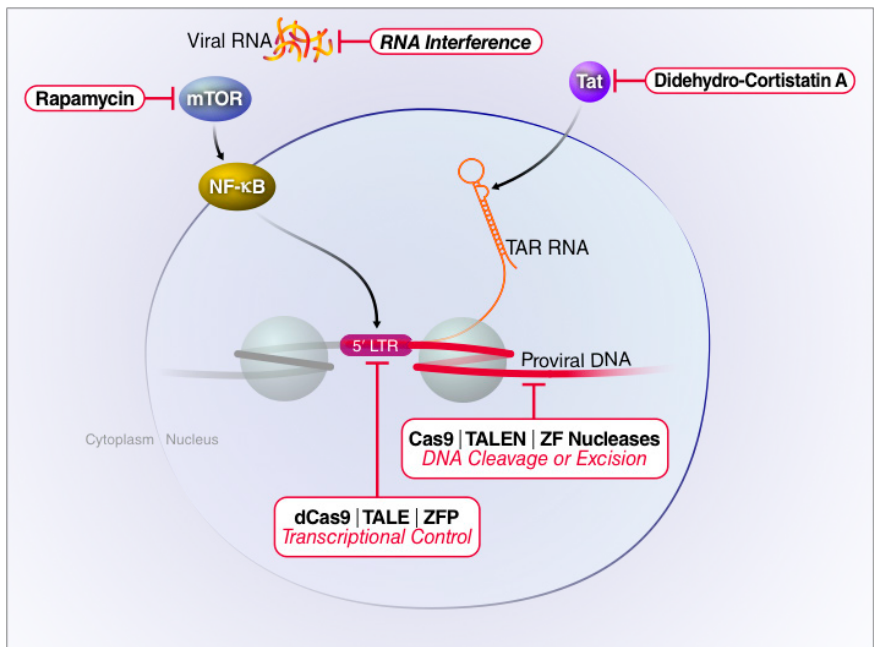
Figure 3. Targeting of host or viral factors to silence latent HIV proviruses. Therapeutics devised to inhibit HIV-1 replication may target different stages of the viral life cycle. The small molecule drug rapamycin blocks viral transcription initiation by inhibiting mTOR and AKT-mediated induction of NF- κ B. Didehydro-cortistatin A interferes with Tat-mediated transactivation by blocking Tat binding to TAR, thereby reducing RNA Pol II elongation. RNA interference predominantly acts by degrading viral transcripts. Gene editing technologies directly target proviral DNA by either excising or corrupting the viral genome. CRISPR interference (CRISPRi) does not cleave the proviral DNA. Rather, a catalytically inactive Cas9 (dCas9) protein is fused to a Krüppel associated box (KRAB) domain and directed to the HIV-1 LTR by sgRNAs. This fusion protein recruits transcriptional repressors producing epigenetic changes associated with gene silencing.